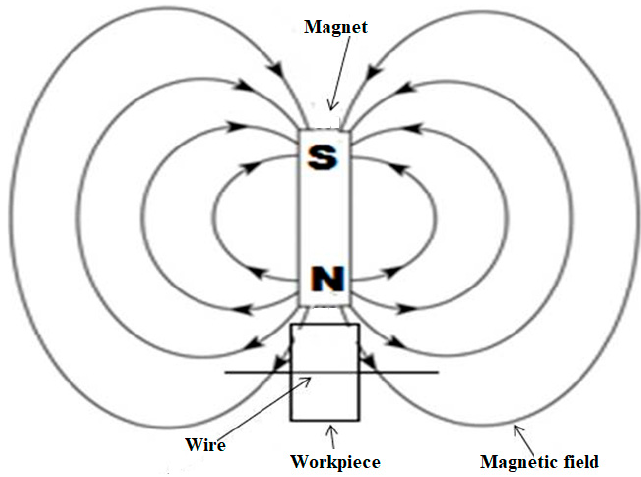
Figure 3. Positioning of the magnet and the workpiece [43].